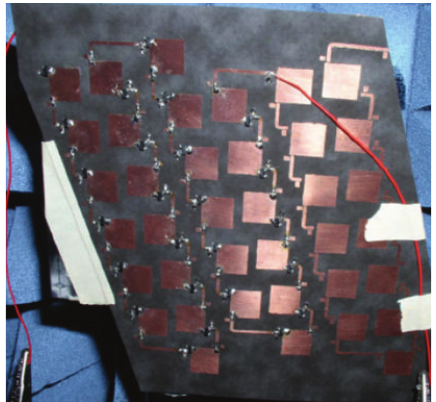
Figure 36: The 10GHz 25-element microwave rectenna array for wireless powering of on-board electronics